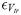
(top) (A) Time evolution of the thick capsule radius (H = 30 μm), shown for the experimental data and the simulation with Model I, indicating the effect of the parameter n and ϵVtr. As the number of data sets on the thick capsule did not suffice to estimate the experimental error, the errors on the thick capsule data (gray zone) were estimated from the spreading on the thin capsule data, by determining the minimum—maximum intervals for the thin capsule data. These were then rescaled by the ratio of thin—thick capsule dilatations and shifted on to the thick capsule curve. (B) Global view of experiment I and II and respective model runs, including a model prediction for a capsule wall thickness H = 60 μm. (C) Simulated evolution of the average pressure in a capsule with H = 30 μm and H = 60 μm.